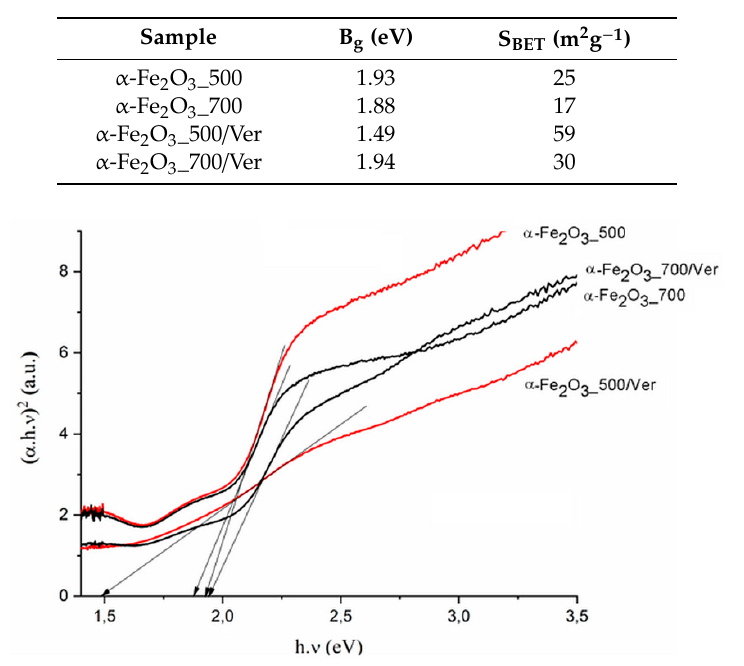
Figure 7. Tauc plot of ( α h ν ) 2 versus photon energy ( h ν ) for pure α -Fe 2 O 3 nanoparticles and α -Fe 2 O 3 nanoparticles/Ver samples at 500 °C and 700 °C.